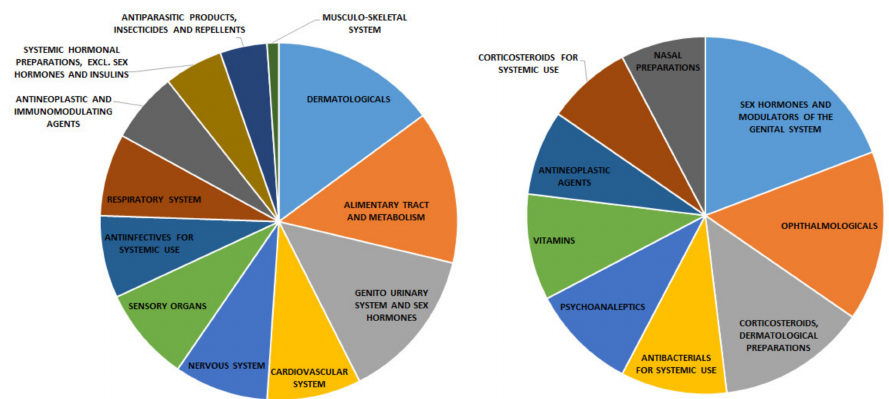
Figure 5. Distribution of ATC codes level 1 ( Left ) and level 2 ( Right ) from all 71 unique drugs identified by the virtual screening